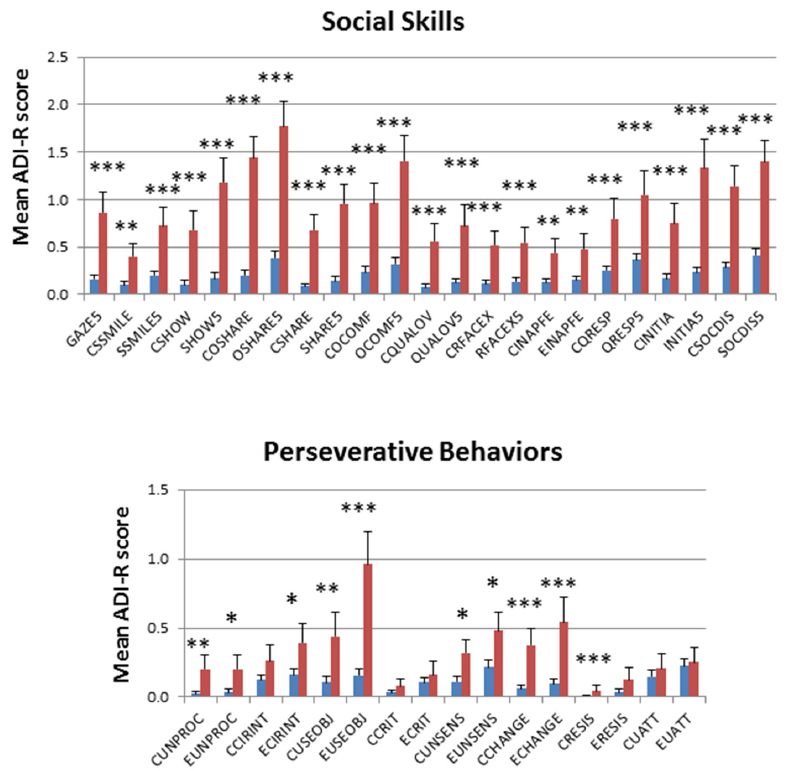
Figure 3. Comparison of average severity scores for dNA.MZ (red bars) and dNA.DZ (blue bars) twins across all ADI-R items (along horizontal axes) used to derive a cumulative trait score. * p -value ≤ 0.05, ** p -value ≤ 0.01, *** p -value ≤ 0.001.